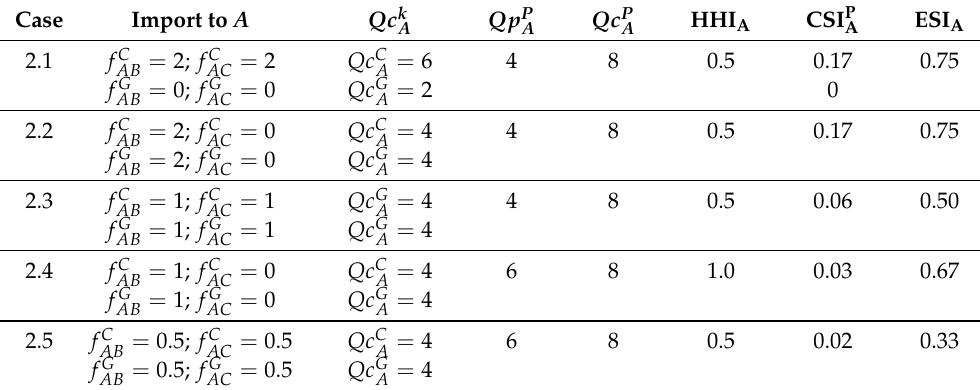
Table 2. Energy Security indexes for economy A , the case with two